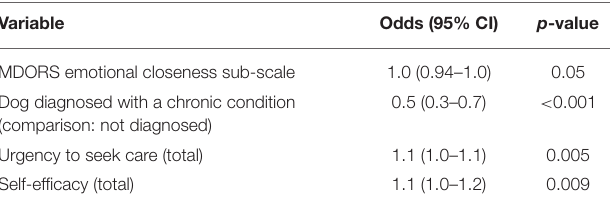
TABLE 8 | Multiple logistic regression model of urgency to seek care given symptoms that could indicate common chronic health conditions.